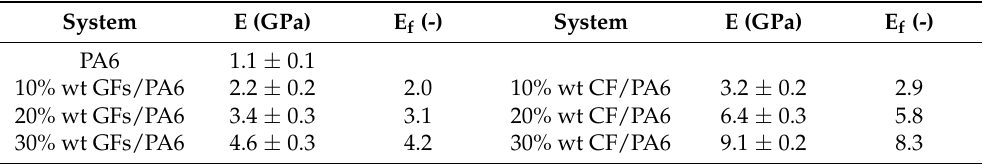
Table A1. Values of the Young modulus E and the corresponding enhancement factor E f (=E of the (nano)composite/E of the pristine polymeric matrix) for the system based on Nylon 6 (PA6) and different loadings of glass fibres (GFs) or carbon fibres (CFs) (system